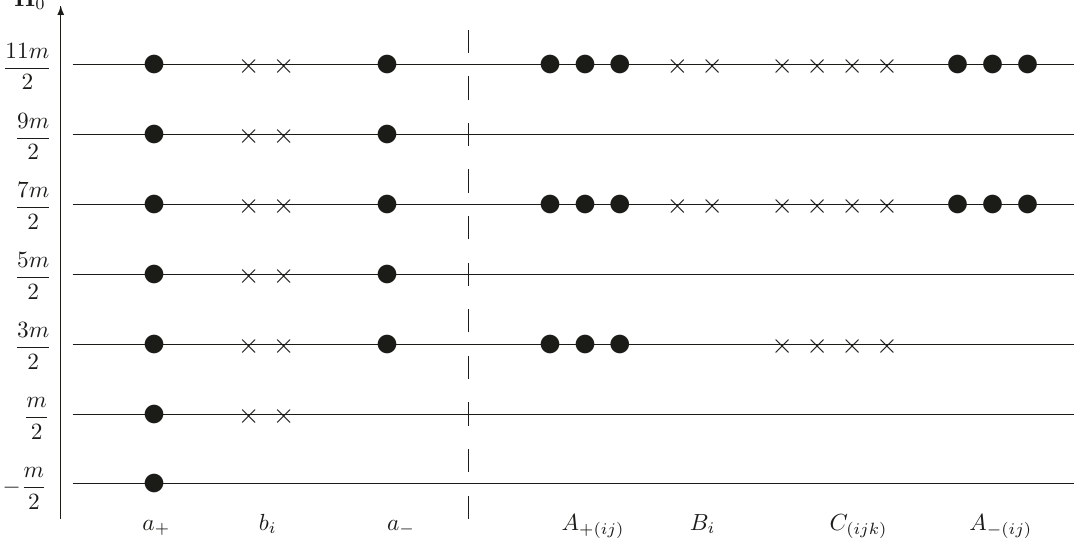
Figure 1 . The degeneracy of energy levels of H 0 for n = 2 and q = 1 / 2. Circles and crosses represent bosonic and fermionic states, respectively. On the left from the dotted vertical line the degeneracy corresponding to harmonic oscillator [14, 19] is shown. On the right side there is shown a sum of SU(2 1) representations specified by their spin values s and coinciding with those found in [27] | for the relevant spin. For the considered simplest case of q = 1 / 2, spin s takes only one value, s =